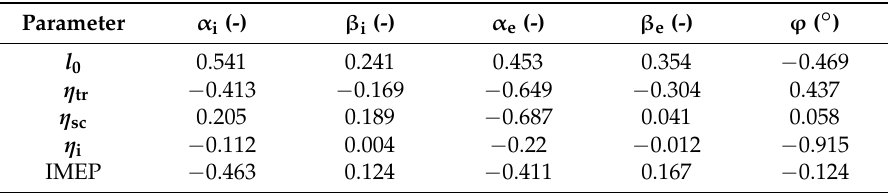
Table 3. Correlation